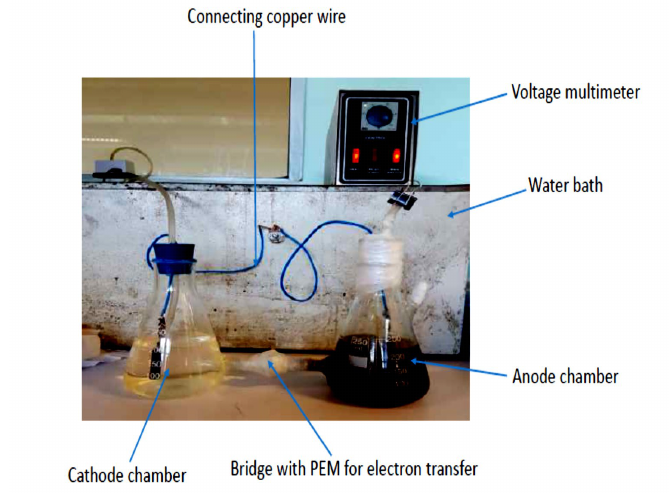
Fig. 1. Fuel cell experimental set